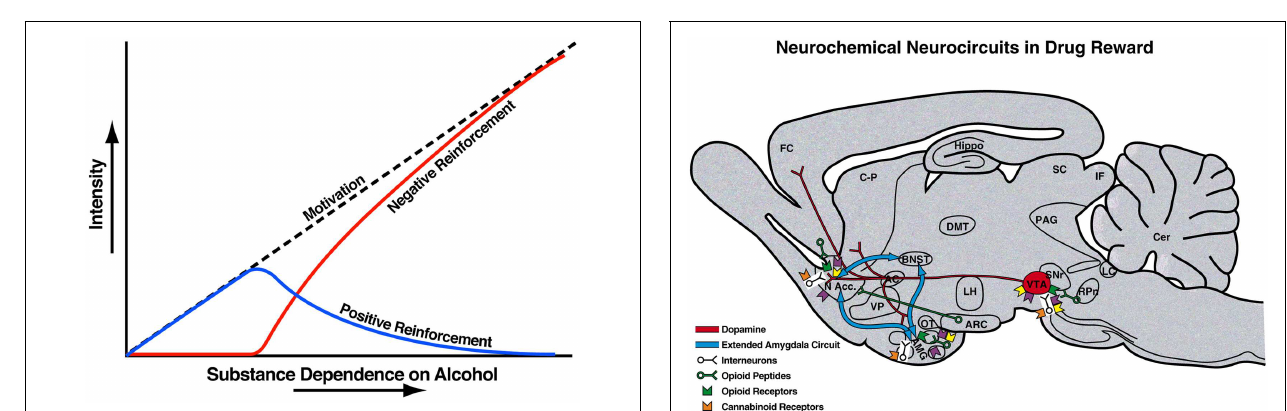
FIGURE 1 |Theoretical framework relating addiction cycle to motivation for drug seeking .The figure shows the change in the relative contribution of positive and negative reinforcement constructs during the development of substance dependence [taken with permission from Ref. (61)].